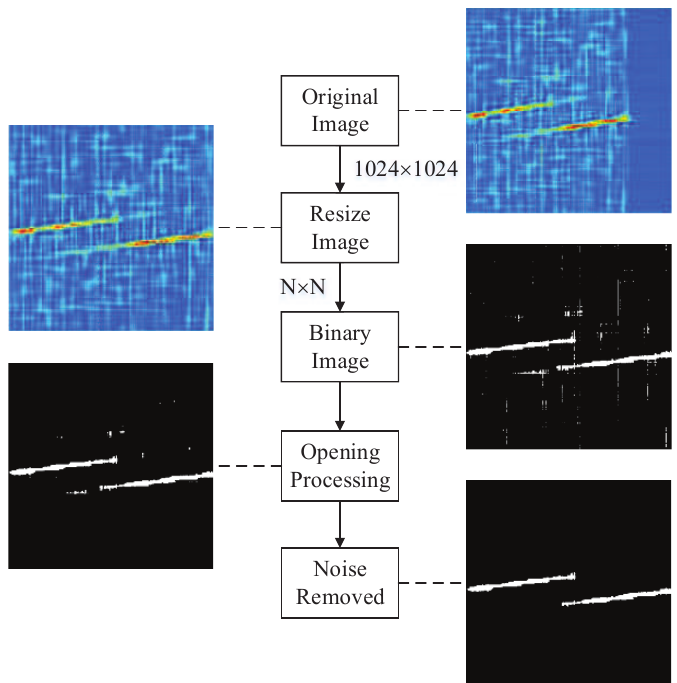
Figure 5. In this figure, P3 code is selected at signal-to-noise ratio (SNR) of –6 dB as an example. Original image is resized by N × N , and the bicubic interpolation is adopted. That is, the output pixel value is a weighted average of pixels in the nearest 4-by-4 neighborhood. By using the opening processing, the binary image is smoother and the noise is removed in the